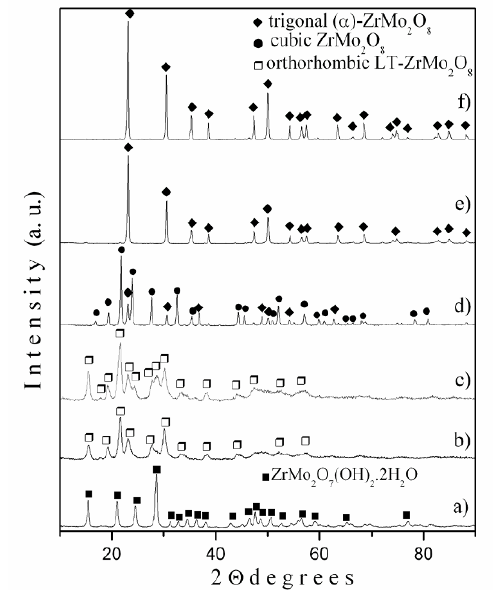
Figure 1. XRD patterns of the ZrMo